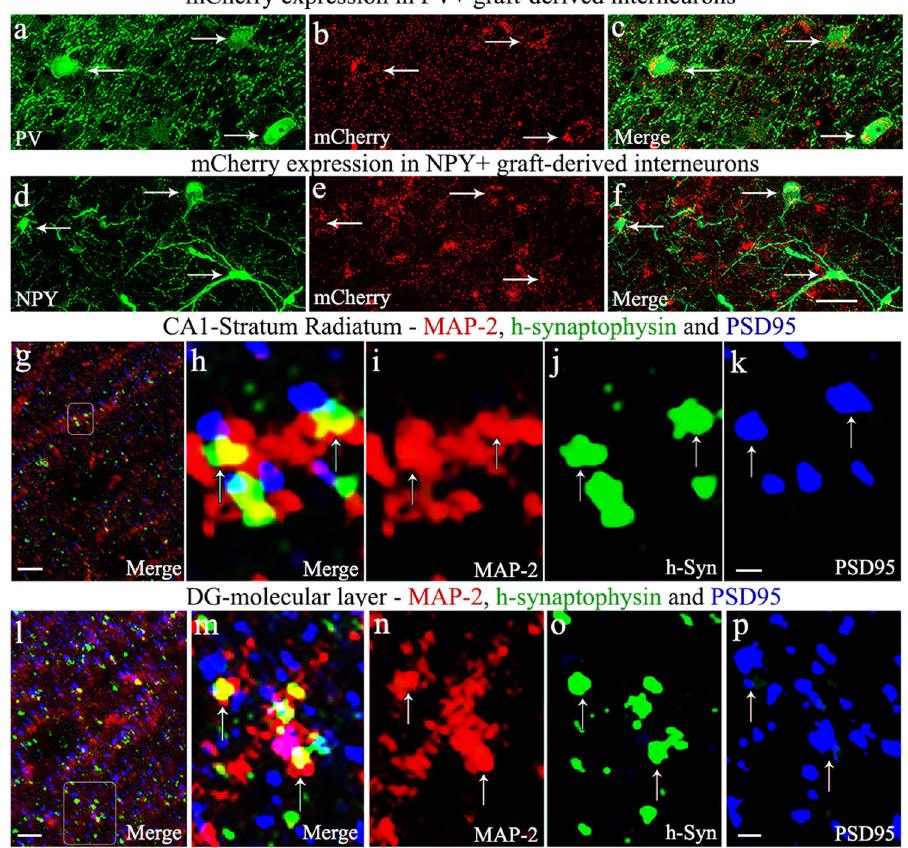
Fig. 7 Graft-derived interneurons expressed hM4Di and formed putative synapses with host neurons. Gi-protein-coupled receptor hM4Di expression (with mCherry reporter) in parvalbumin (PV) and neuropeptide Y (NPY) expressing interneurons derived from human medial ganglionic eminence progenitor cell grafts in the hippocampus of chronically epileptic rats ( a – f ), and putative synapse formation between graft-derived axons and host neurons ( g – p ). Note that mCherry is apparent in PV and NPY + interneurons derived from graft-derived cells ( a – f ). g , l illustrate putative synapse formation between graft-derived presynaptic boutons (green colored structures expressing human synaptophysin (hSyn) and the host postsynaptic density protein 95 (PSD95, red particles) elements on microtubule-associated protein-2